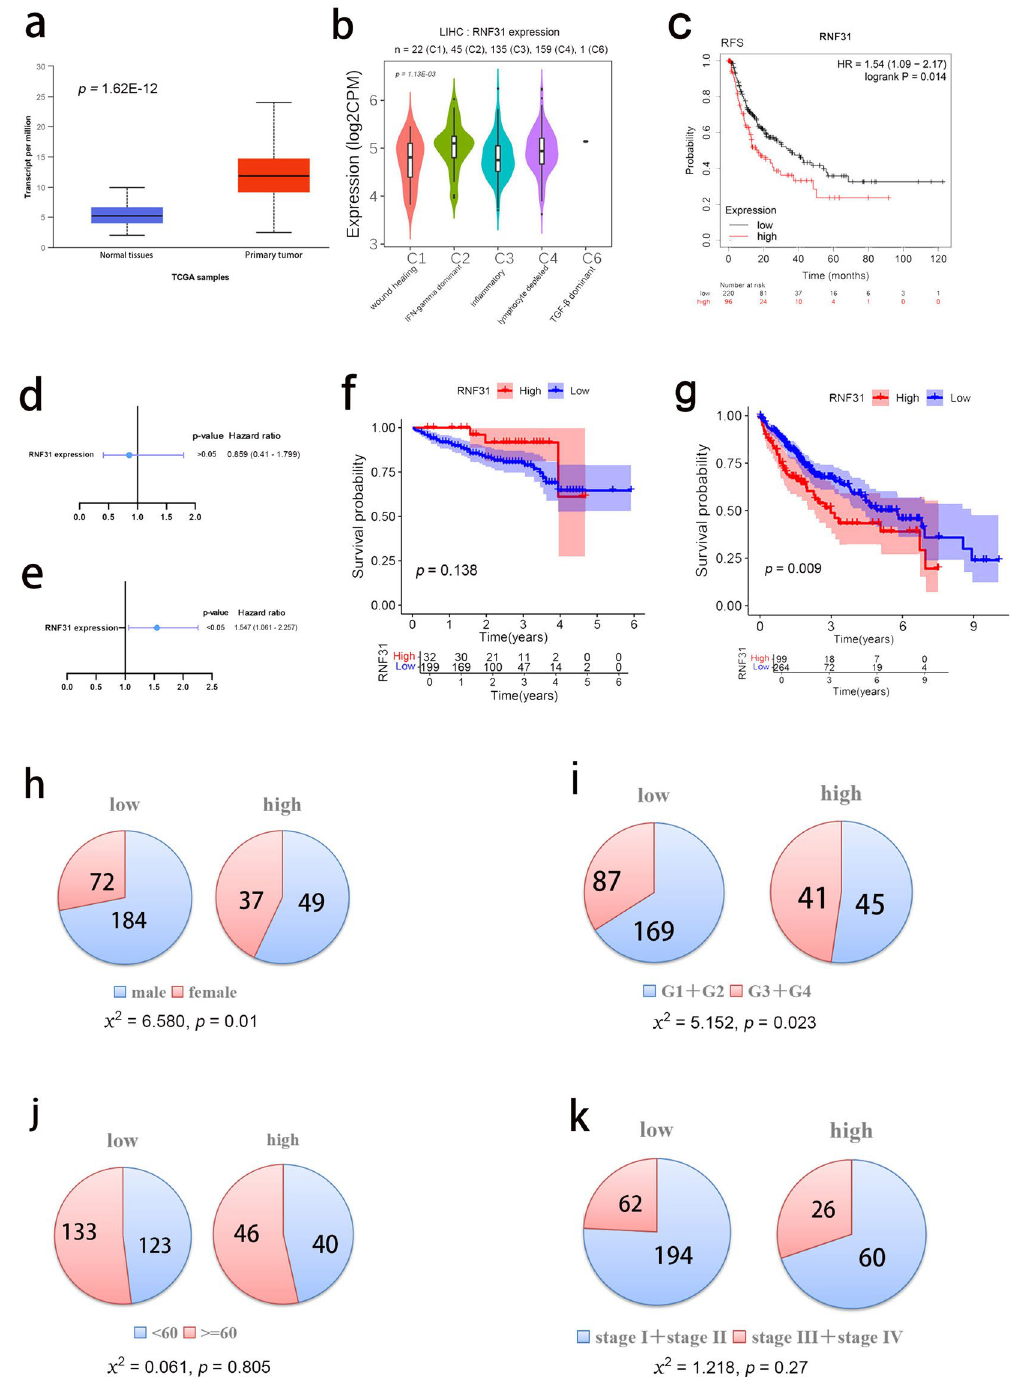
Figure 4. Expression of RNF31 in LIHC. ( a ) Expression of RNF31 in LIHC based on sample type. ( b ) Expression levels of RNF31 in different immune subtypes of LIHC. ( c ) Recurrence-free survival (RFS) curves of patients with LIHC. ( d ) Impact of RNF31 on OS in ICGC LIHC samples (COX regression). ( e ) Impact of RNF31 on OS in TCGA LIHC samples (COX regression). ( f ) OS curve based on ICGC LIHC samples. ( g ) OS curve based on TCGA LIHC samples. ( h – k ) Distribution of gender, tumor grade, age and tumor stages in high and low groups and chi-square test results (patients with RNF31 expression below the third quartile were assigned to the “low” group, and patients with expression above the third quartile were assigned to the “high” group, G1: grade1, G2: grade2, G3: grade3, G4: